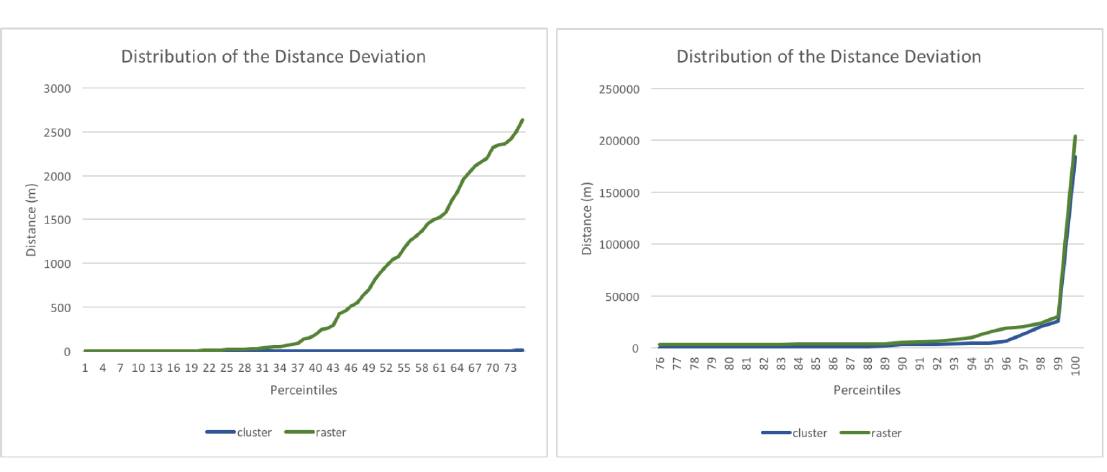
Figure 8. Distribution of the distance deviation for both the clustered as well as the rastered input. The right figure shows the last quartile at a different scale.